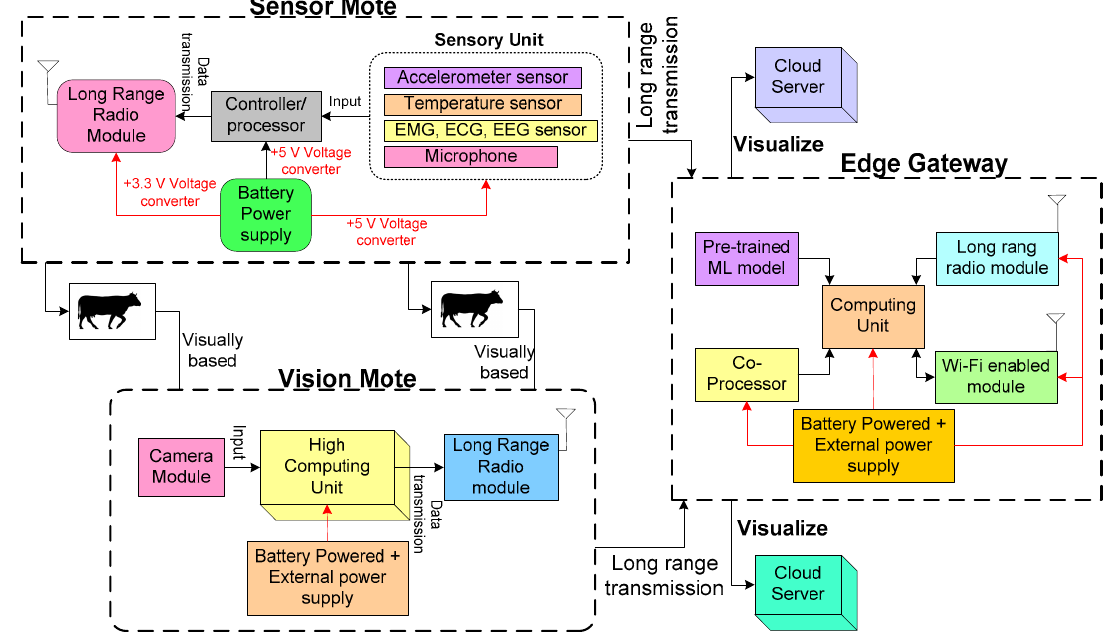
Figure 4. Architecture of Real-time animal health tracking.